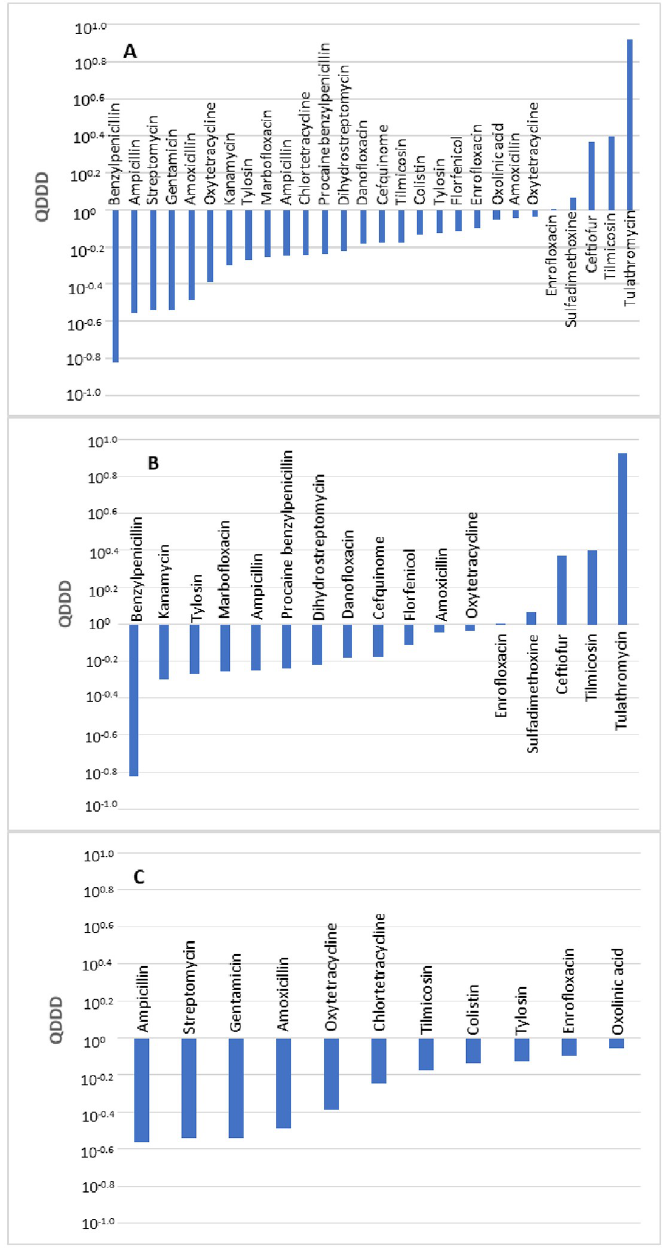
Fig 2. Comparison of the defined daily doses in Japan (DDDjp) of antimicrobial agents approved for use in cattle with the corresponding values of the European Medicines Agency (DDDvet). Bars indicate an antimicrobial agent for which both DDDjp and European values of DDD (DDDvet) values are available with QDDD (DDDjp/DDDvet) values in ascending order. Comparison of all antimicrobials (A), antimicrobial agents for injection (B) and antimicrobial agents for oral administration (C). Comparison was not made by number of substances because there was no combination antimicrobial agent for which DDDvet and DDDjp values were available. deviations between the DDDjp and DDDvet values (Table 8). When compared with the EMA guideline values, the oral solutions with the active substance ampicillin showed a lower daily dose with QDDD of 0.15 and amoxicillin with a higher daily dose with QDDD of 1.88 (Table 9).